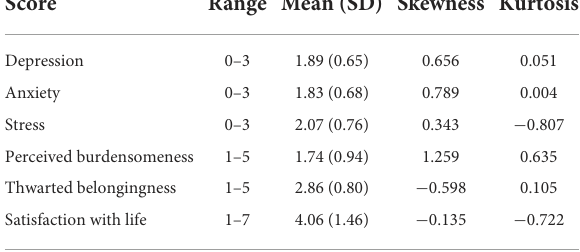
TABLE 2 Descriptive statistics of research